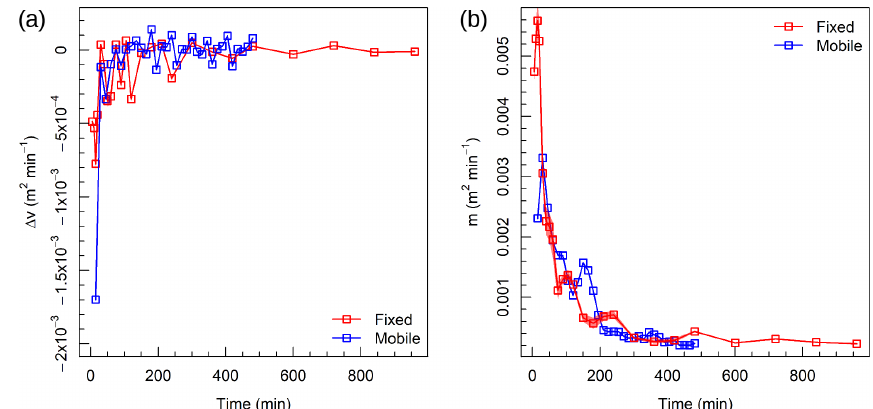
Figure 5. Panel (a) shows the rates of net volumetric change per unit width. Net volumetric change is calculated as the difference between volumes of erosion and deposition between successive DEMs. Panel (b) shows the rates of morphologic activity per unit width. Morphologic activity is calculated as the sum of volumes of erosion and deposition between successive DEMs.